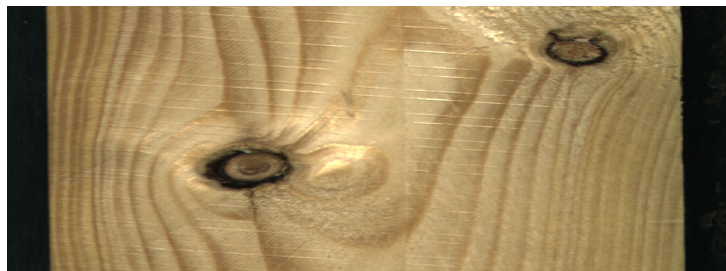
Figure 3. A dataset example of a sawn timber surface with dead